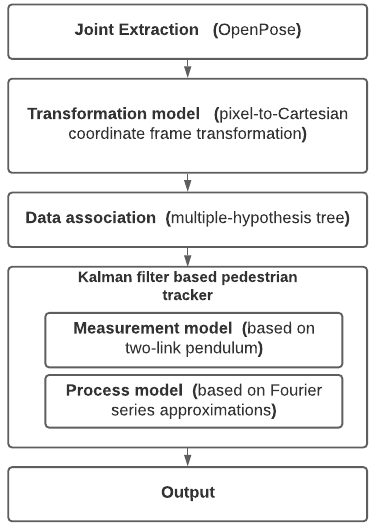
Figure 2. General framework of a tracker.